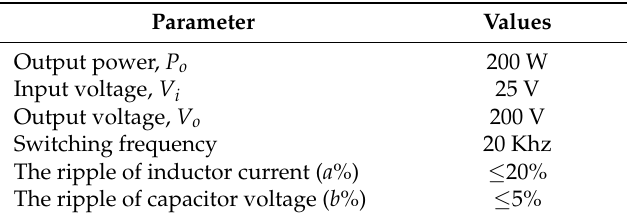
Table 5. Parameters for verification.